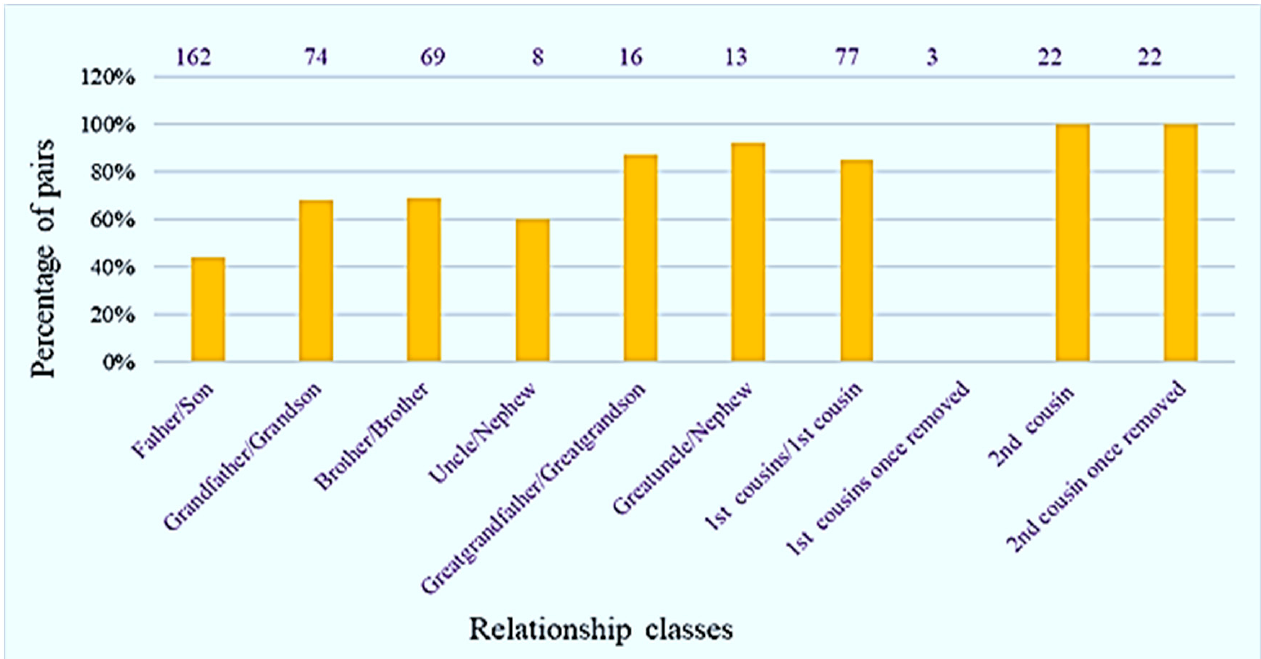
Figure 2. Pairs of male paternal relatives ( n = 536) separated by one to seven meiosis with at least one mutation. Values above the bars represent the total number of pairs for each relationship class.